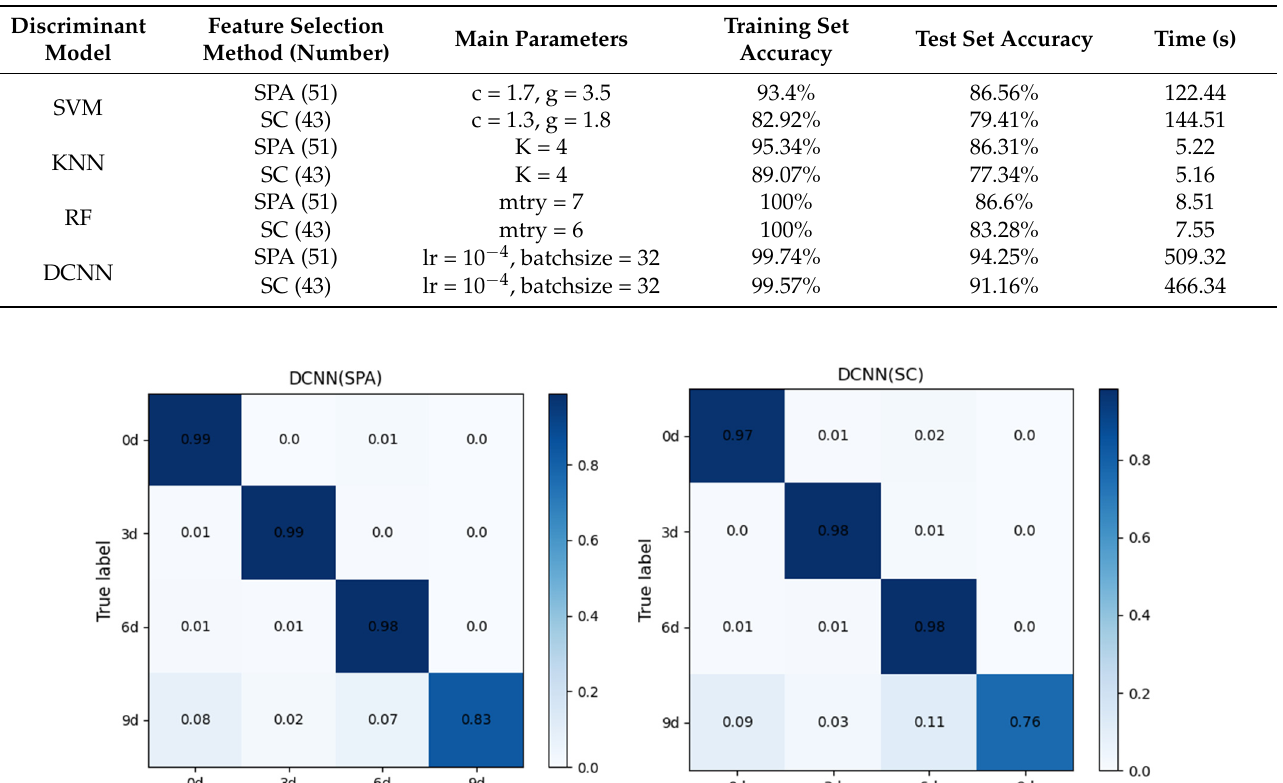
Table 6. Results of viability detection on characteristic bands.